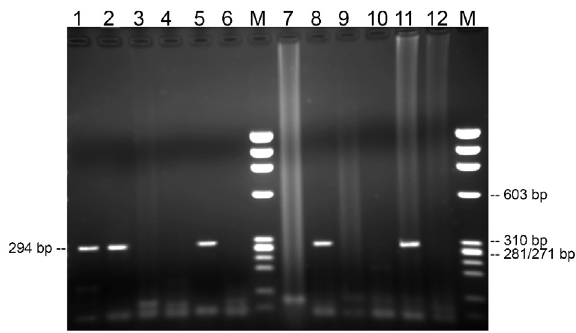
Figure 1 glmM (294 bp) is illustrated in the agarose gel (2%). Lanes 1, 2, 5, 8, positive samples; lane 11, positive control; lane 12, negative control; lanes 3, 4, 6, 7, 9, 10, negative sam- ples. Lane M, molecular weight markers (DNA molecular Weight Marker IX, Roche).